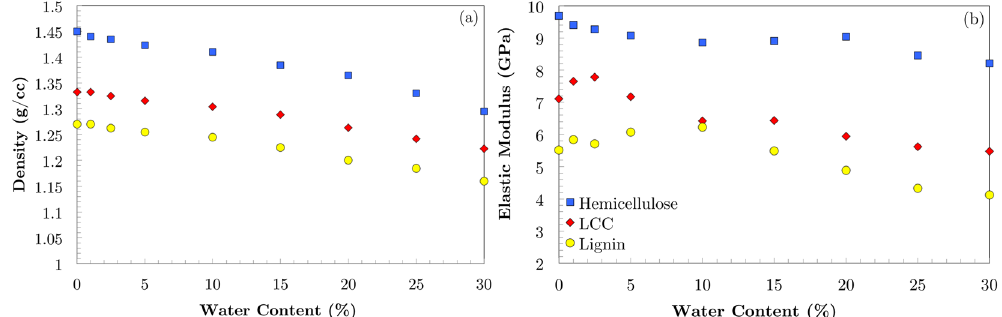
Figure 3. Variation of density and elastic modulus of hemicellulose, lignin and LCC with increasing MC. Hemicellulose density constantly decreases with growing MC whereas LCC and lignin are resistant to the variation of density at very low MC. Hemicellulose elastic modulus constantly decreases with increasing MC whereas LCC and lignin elastic moduli increase at low MC and then